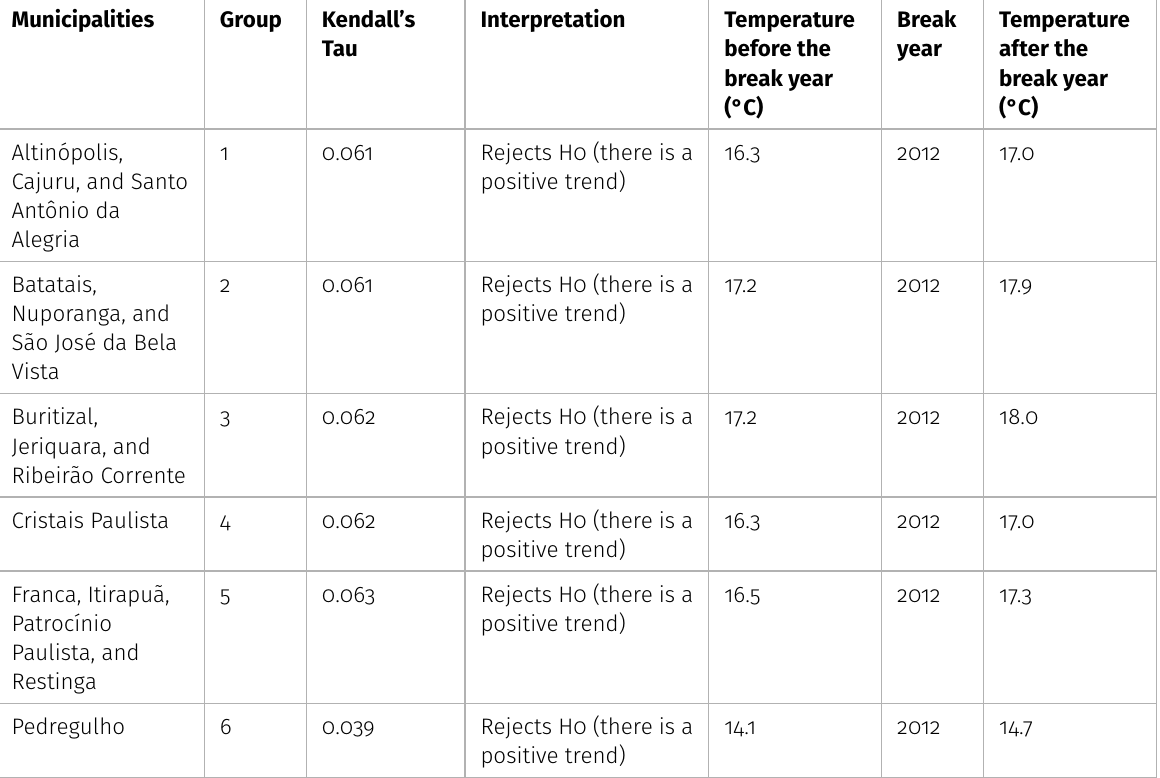
Table II. Mann-Kendall test and Pettitt test values for minimum temperature. Municipalities Group Kendall’s